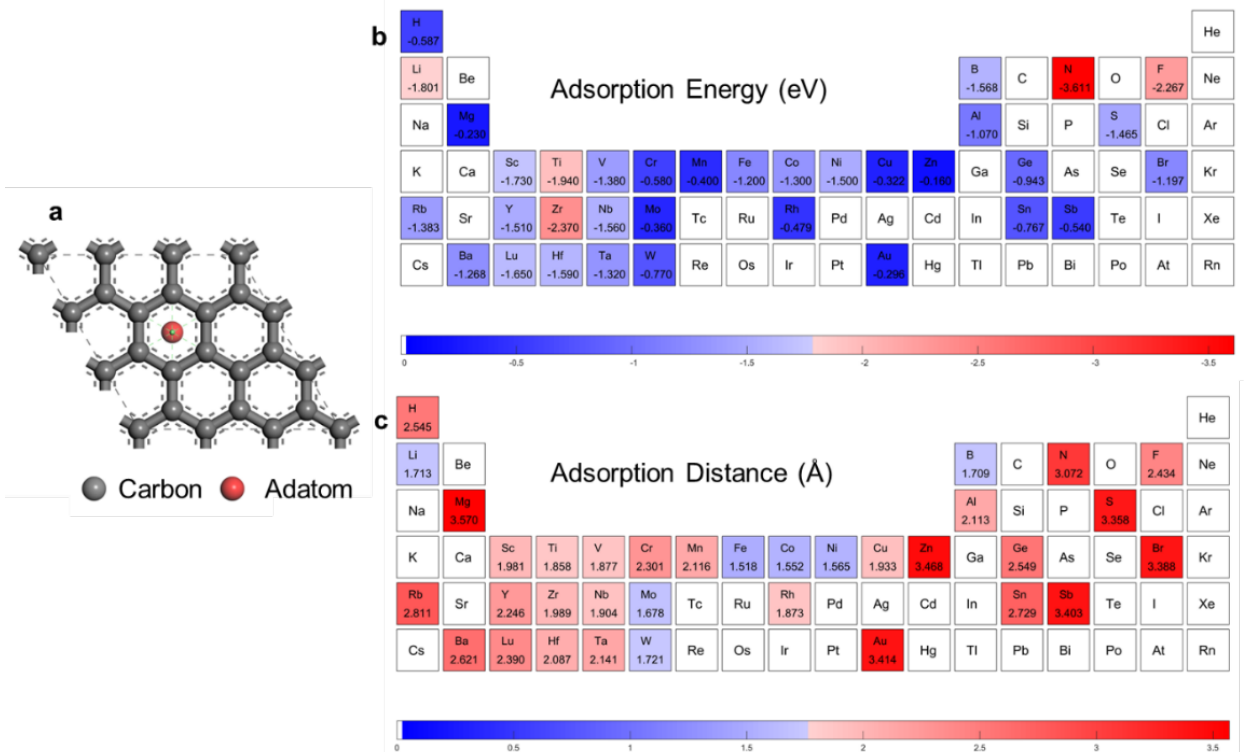
Figure 1. DFT calculation results. ( a ) Adatom adsorption structures. The adatom is put at the hollow site. Data visualization of first principle calculated. ( b ) Adsorption energy. ( c ) Adsorption distance.